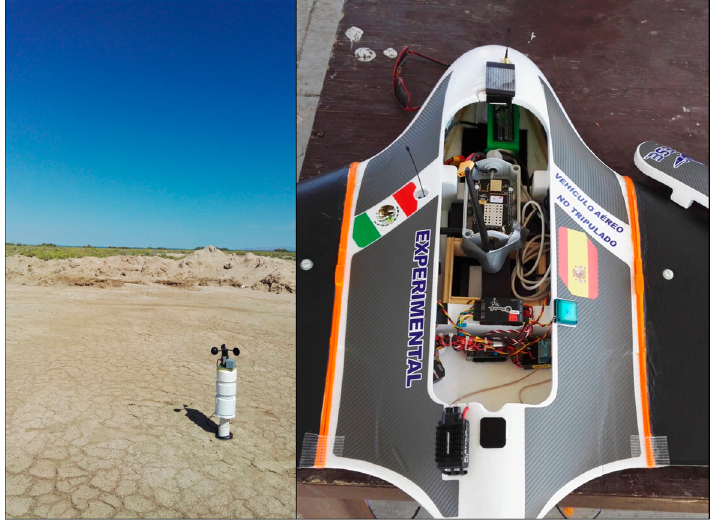
Figure 13. Initial flight test. To the left the sensor buoy placed on the ground and to the right the UAV with the master node mounted inside.